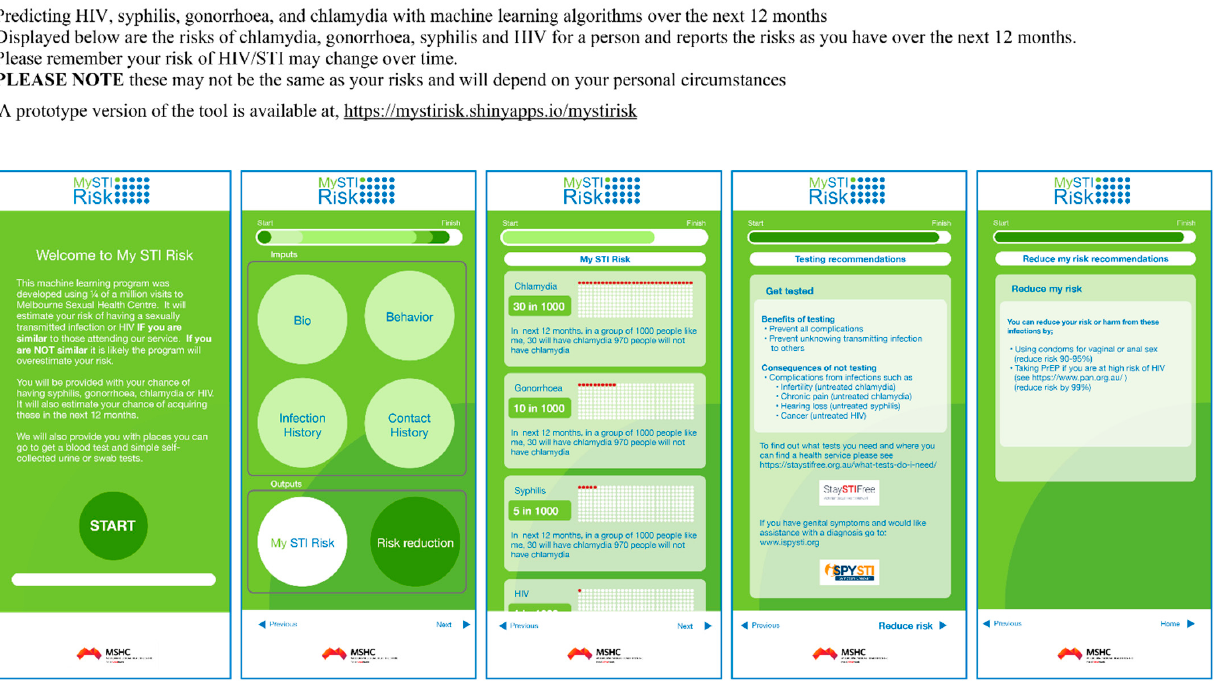
Figure 3. 12-month HIV/STI risk-prediction tool’s interface and output. STI: syphilis, gonorrhoea, and chlamydia.